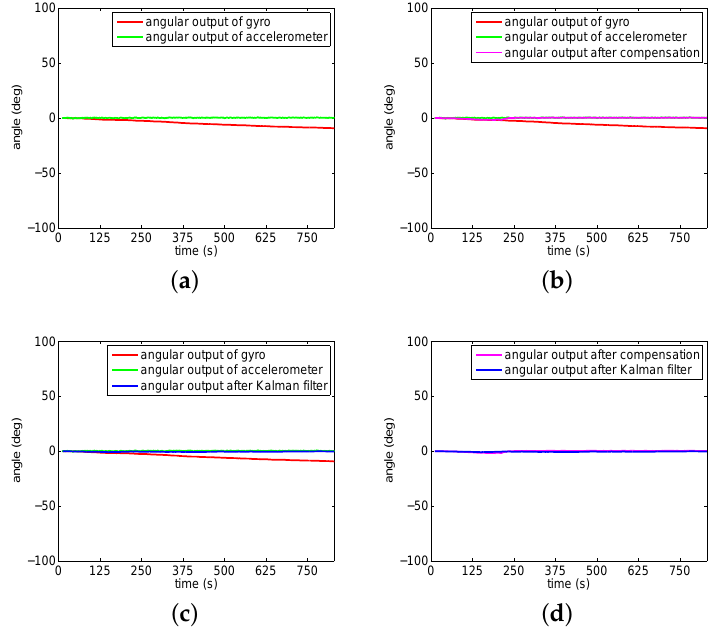
Figure 8. Experiment 1 (Red line is angular output of gyro. Green line is angular output of accelerometer. Carmine line is angular output after compensation. Blue line is angular output after Kalman filter.). ( a ) Angular outputs of gyro/accelerometer; ( b ) Applying the proposed compensation method; ( c ) Applying Kalman filtering method; ( d ) Comparison of two